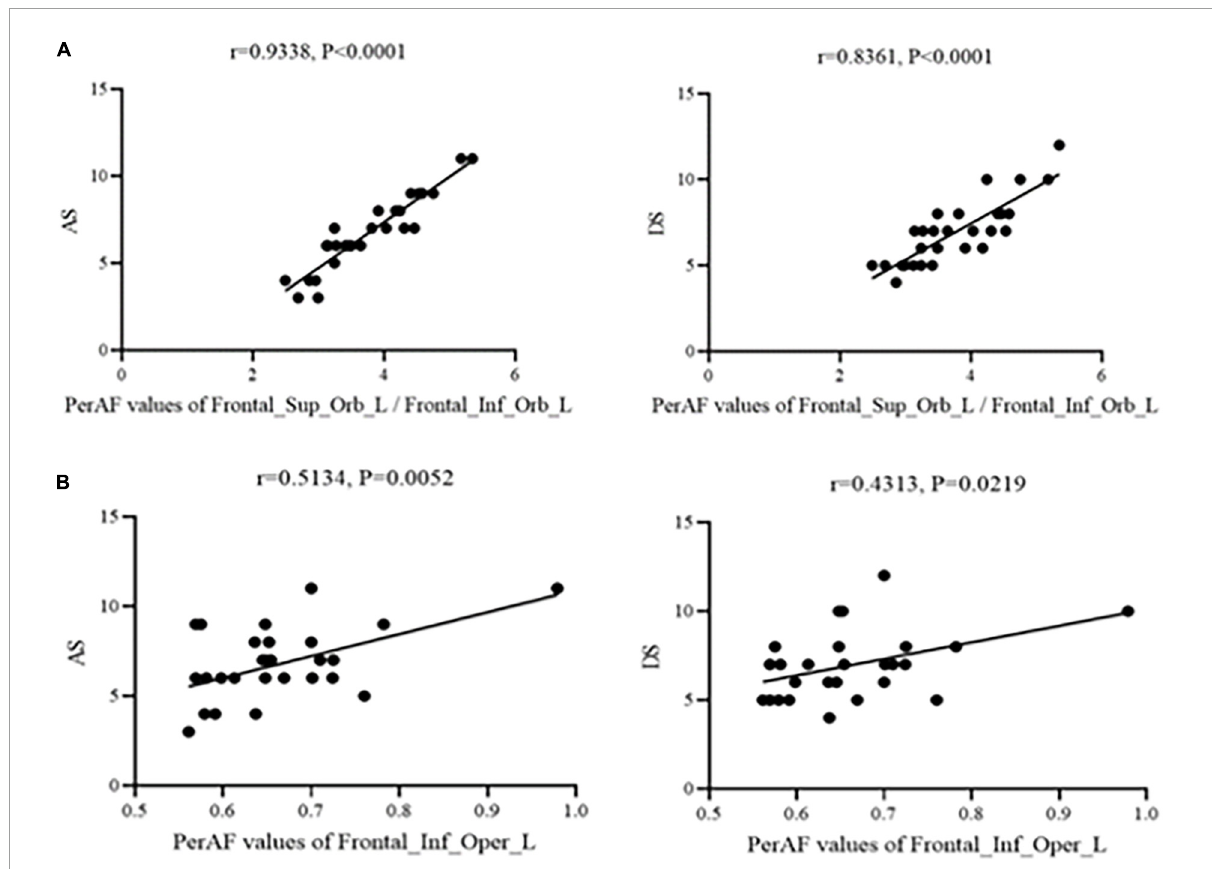
FIGURE3 Correlation between PerAF and HADS scores. (A) Stands for monocular blindness group and (B) stands for healthy control group. In the MB group, the PerAF value of Frontal_Sup_Orb_L/Frontal_Inf_Orb_L showed a positive correlation with AS ( r = 0.9338, p < 0.0001) and DS ( r = 0.8361, p < 0.0001), and the value of Frontal_Inf_Oper_L also showed a positive correlation with AS ( r = 0.5134, p < 0.05) and DS ( r = 0.4313, p < 0.05). PerAF, percent amplitude of fluctuation; AS, anxiety scores; DS, depressed scores; MB, monocular blindness.